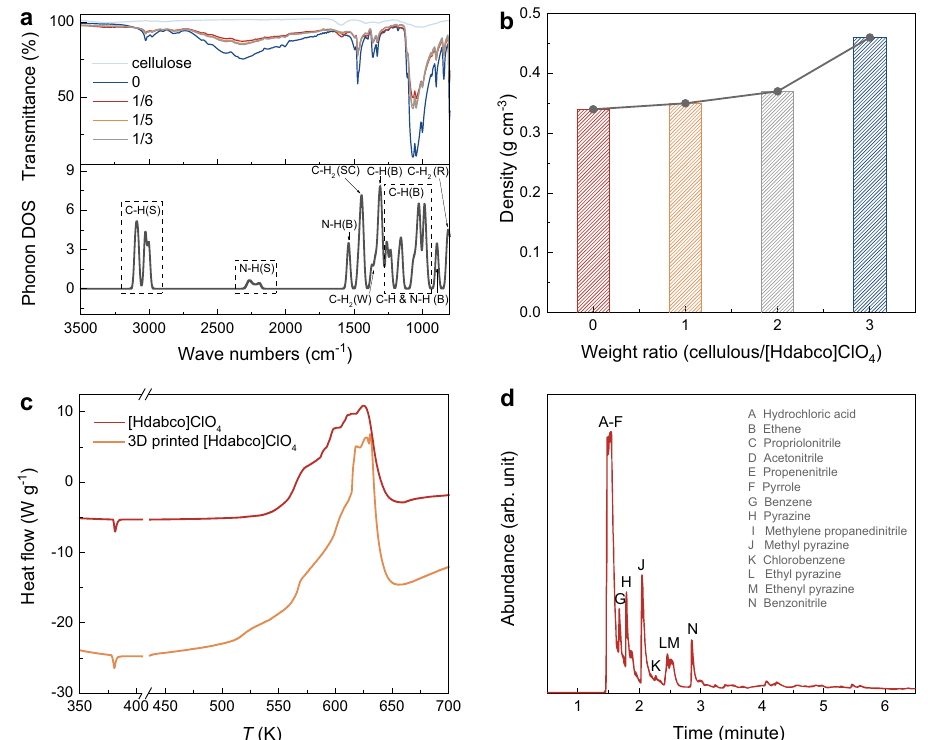
Fig.4|Structuralpropertiesandthermalanalysisof3Dprinted[Hdabco]ClO 4 . a FTIR spectra for cellulose and printed sample different weight ratio (cellulose/ [Hdabco]ClO 4 ). Calculated phonon density of states (DOS) for [Hdabco]ClO 4 . bending (B); stretching (S); rocking (R); wagging (W); scissoring (SC). The phonon dispersion is shown in Supplementary Fig. 18. b Weight ratio (cellulose/[Hdabco]